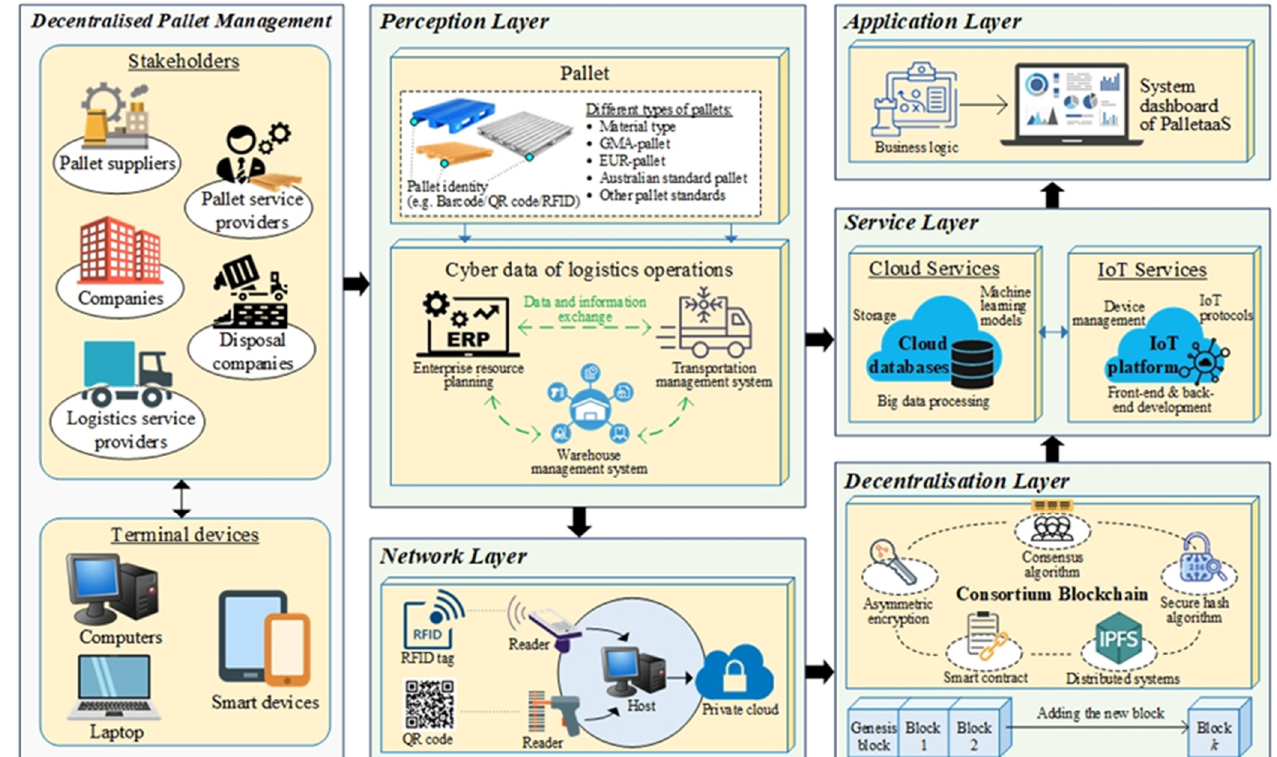
Figure 2. Layered architecture of PalletaaS for the decentralised pallet management.